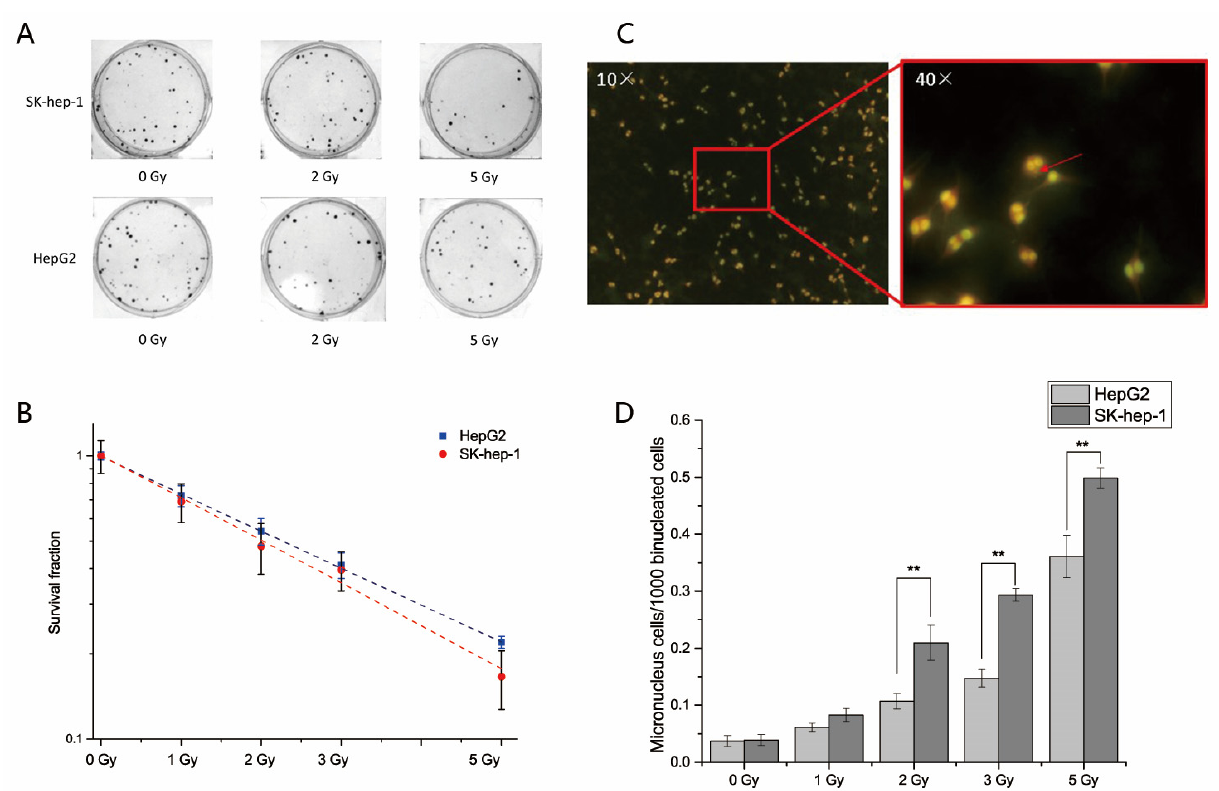
Figure 3. Statistical analysis and schematic diagrams of clone formation and micronuclei formation assays in irradiated HepG2 and SK-hep-1 cells. ( A ) Pictures of stained colonies from the clonogenic assay experiment. ( B ) The dose-survival curve of HepG2 and SK-hep-1 cells 6 h after X-ray irradiation. ( C ) Schematic diagram showing micronuclei formation. ( D ) The micronuclei formation rates of HepG2 and SK-hep-1 cells 6 h after X-ray irradiation. ** p < 0.01 compared between the two cells.